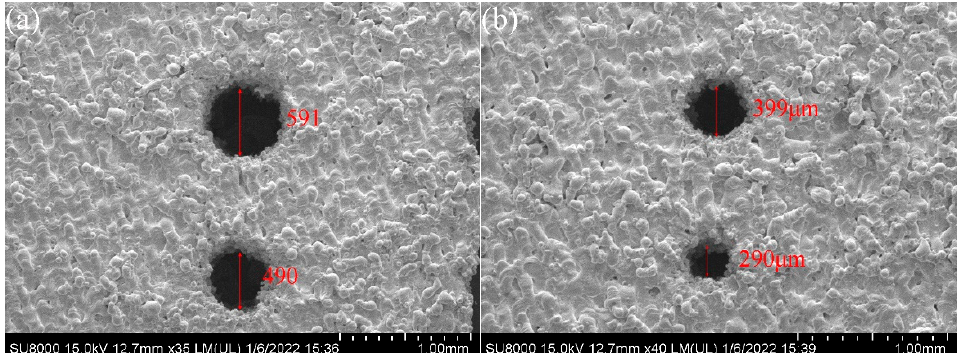
Figure 15. SEM of microchannel with diameter of ( a ) 600 µ m, 500 µ m, ( b ) 400 µ m.